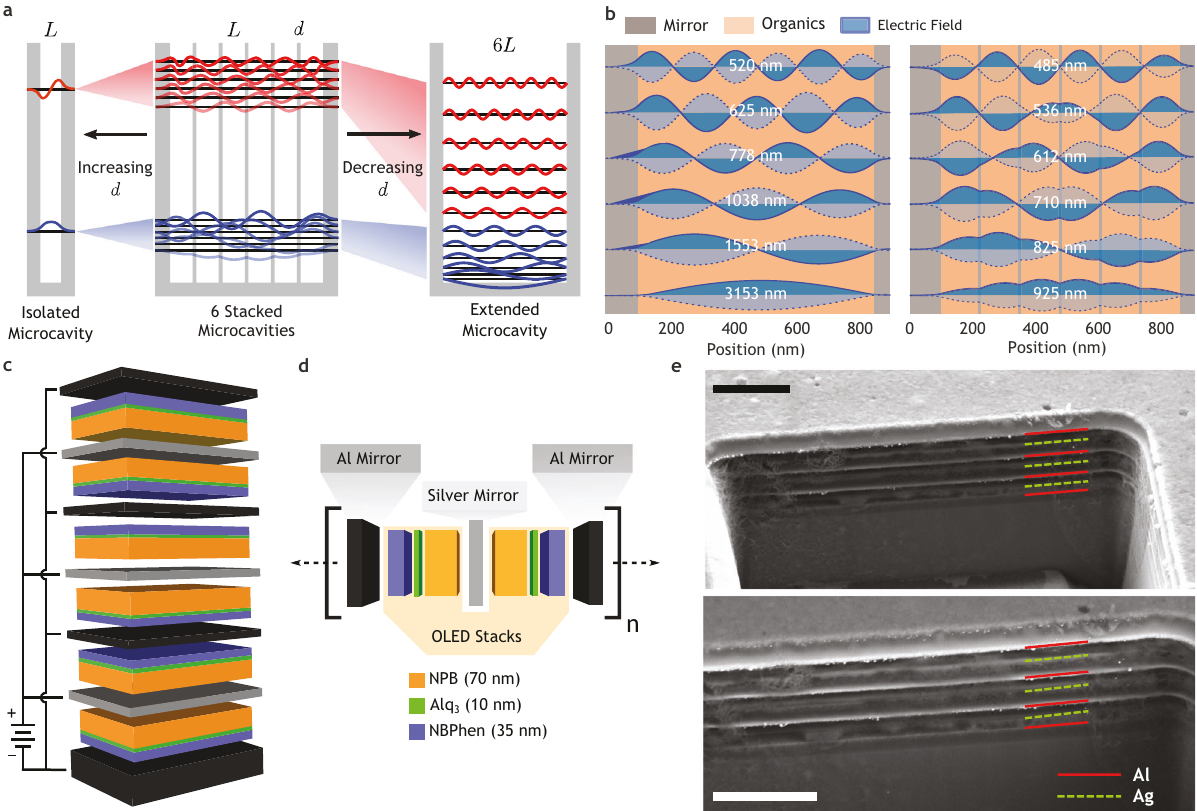
Fig. 1 Stacked microcavity OLEDs. a Schematic showing the formation of energy bands through the interaction of the isolated single-cavity and extended cavity modes. Increasing the mirror thickness reduces the bandwidth, compressing the states to those of the single-cavity. Reducing the mirror thickness increases the bandwidth, and the states approach the extended cavity modes. b Transfer matrix simulations of the internal electric fi eld pro fi les at normal incidence of the fi rst photonic band of an ideal extended cavity of length 6L = 720 nm (left) and an ideal six-layer stacked microcavity device with L = 120 nm and d = 10 nm (right). Perturbation of the states by the internal mirrors increases their energy. c Device schematic of a six-layer stacked microcavity device with alternating Al and Ag mirrors of uniform 30 nm thickness. The microcavities are electrically driven in parallel with shared anodes and cathodes. d Schematic of a single unit cell of the photonic crystal consisting of two identical OLED devices with opposite orientation. Mirror thicknesses were varied between 10 and 30 nm. NPB (N,N'-Bis(naphthalen-1-yl)-N,N'-bis(phenyl)-benzidine), Alq 3 (Tris-(8-hydroxyquinoline)aluminum, NBPhen (2,9-Bis(naphthalen-2-yl)-4,7-diphenyl-1,10-phenanthroline). e Cross-sectional SEM image of an N = 6 device taken at 45 ∘ tilt prepared by focused ion beam, using secondary electron (top) and backscatter (bottom) detectors. Scale bars 1 μ